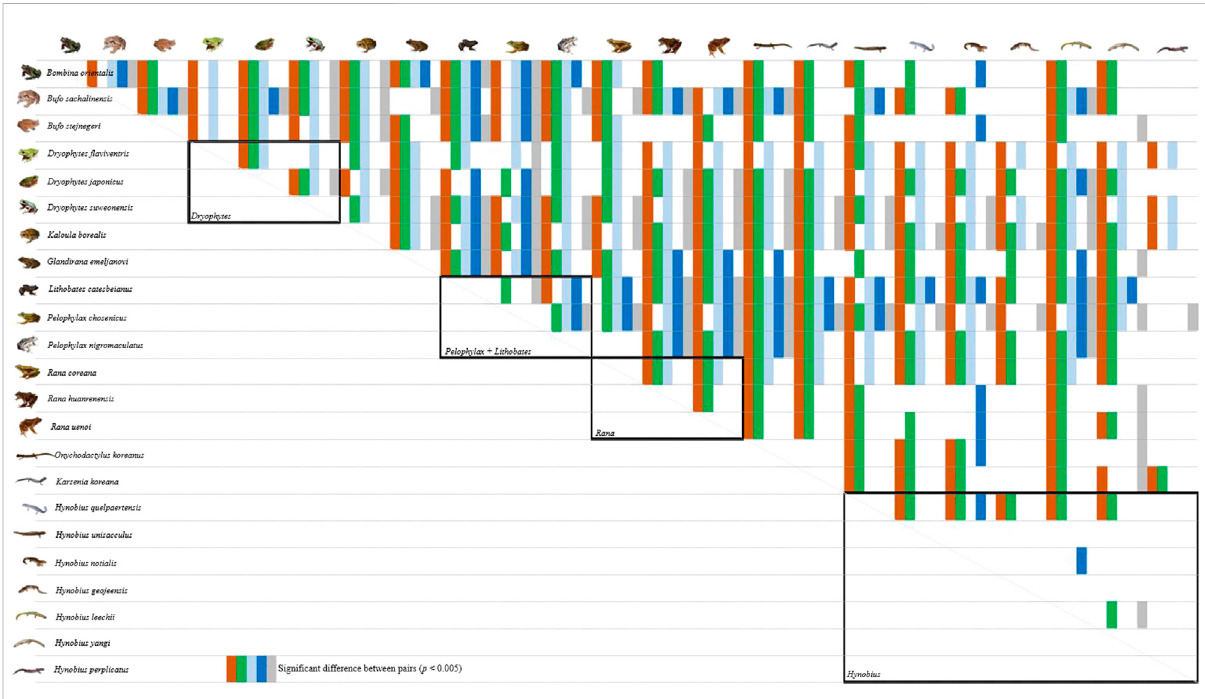
FIGURE 3 Result of the post-hocTuckey test to compare the habitat use between all species pair. A ‘ colouredcell ’ represents a p < 0.005 (exact results in Annex 1), and thus a different use in habitat between the species. The colour coding is such as brown is woody, green is herbaceous, light blue wetland, dark blue is water, and grey is urban. Intra-generic comparisons are highlighted by black boxes. The analysis is based on 8,763 citizen science observations collected between 02 March 1997 and 01 December 2020 downloaded from the platform